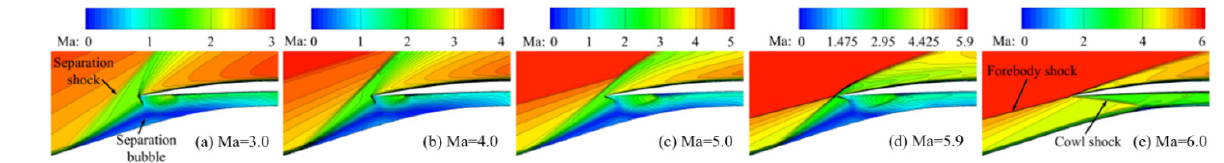
Figure 6. Mach number contours during the first type of starting process ( δ = 3°).